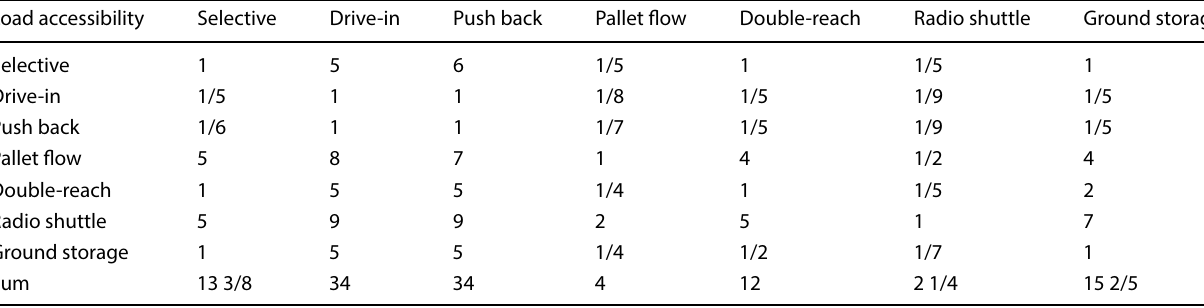
Table 12 Comparison between the alternatives in term of load